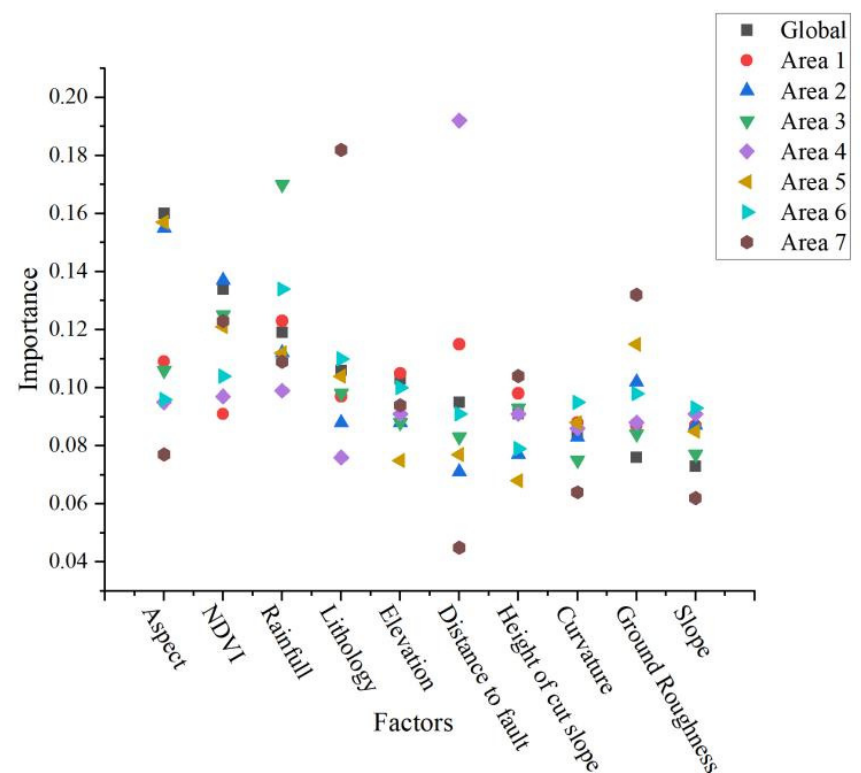
Figure 10. The importance of evaluation factors varies by region.